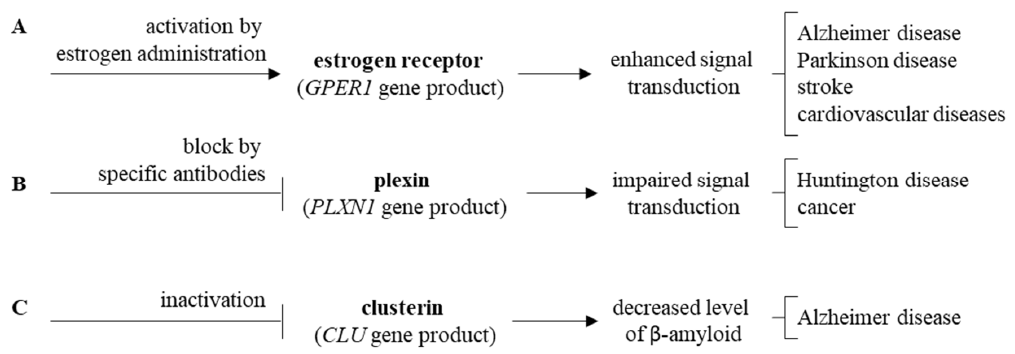
Figure 6. Proposed new therapeutic strategies targeting estrogen receptor ( A ), plexin ( B ), and clusterin ( C ).